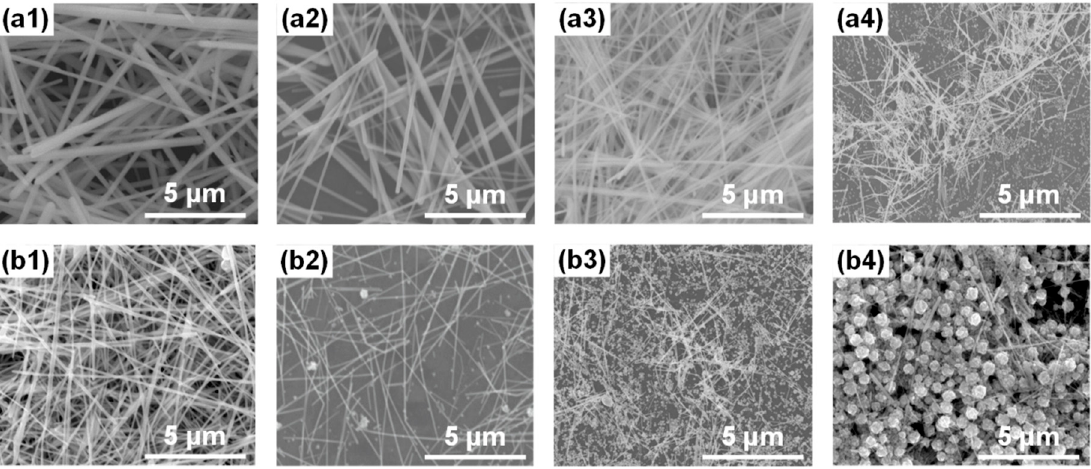
Figure 2. SEM images of products synthesized with different additions of ( a1 – a4 ) NaCl and ( b1 – b4 ) NaBr. The amount is ( a1 , b1 ) 150 µM, ( a2 , b2 ) 300 µM, ( a3 , b3 ) 600 µM, and ( a4 , b4 ) 900 µM, respectively.